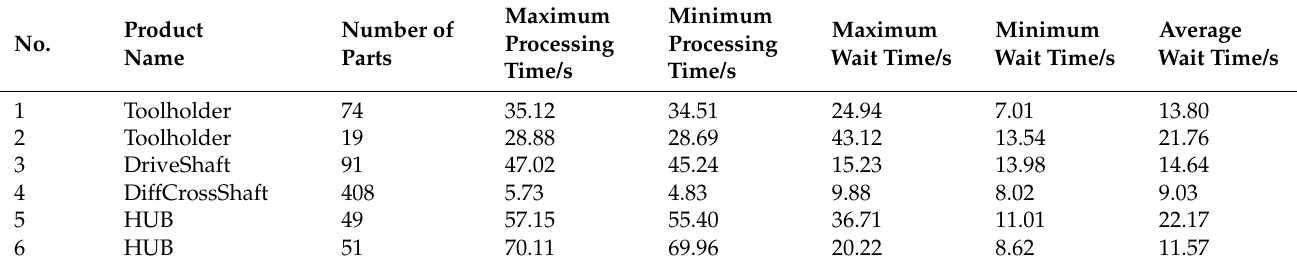
Table 2. Identification results.